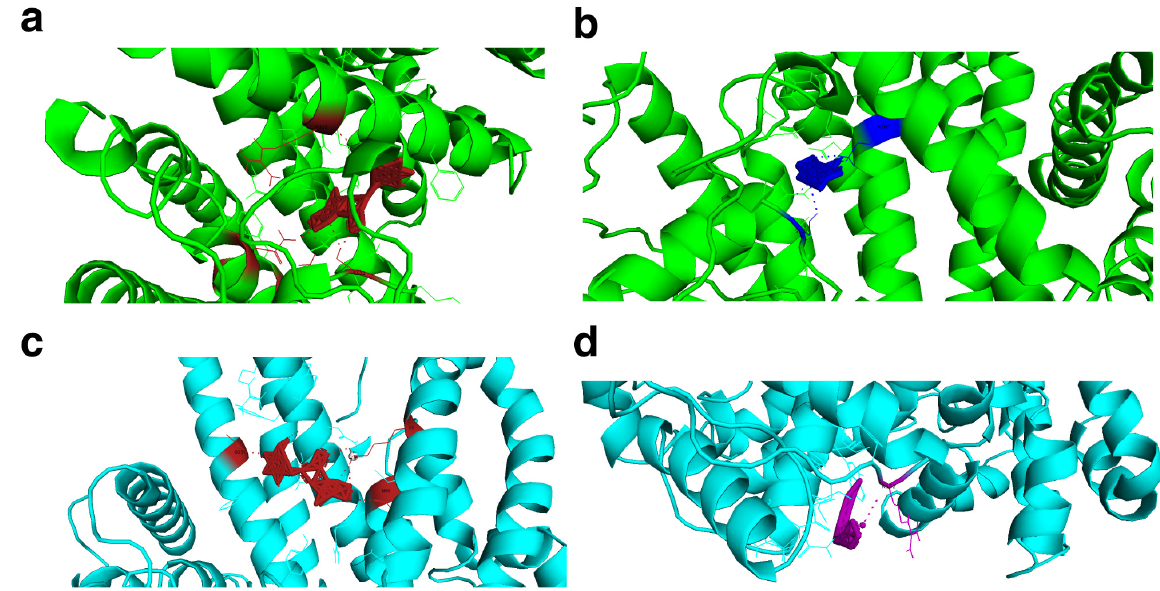
Figure 4. Visualization of protein-ligand interactions for both PHISTb/RLP1 reference and mutant proteins. ( a and b ) visualizations of alpha carrageenan (firebrick) and fucoidan (blue) drug compounds interacting with PHISTb/RLP1 reference protein structure (green) at specific binding sites. The interacting residues and polar contacts are shown in firebrick and blue PyMOL colours respectively. ( c and d ) are visualizations of alpha carrageenan (firebrick) and ghatti sulfate (purple) compounds interacting with PHISTb/RLP1 mutant protein structure binding pockets. The interacting residues and polar contacts are shown in firebrick and purple PyMOL colours, respectively. These specific interactions reveal potential inhibitory activity of these compounds against PHISTb/RLP1 proteins.